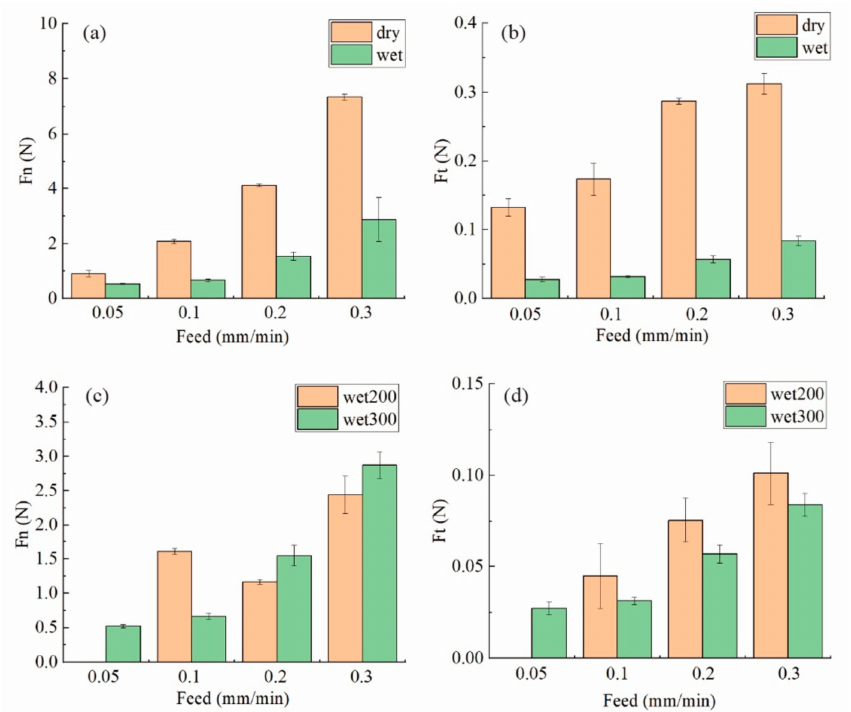
Figure 2. The thrusting force and normal force for ( a , b ) dry cutting and wet cutting conditions; ( c , d ) wet cutting with 200 and 300 rpm spindle